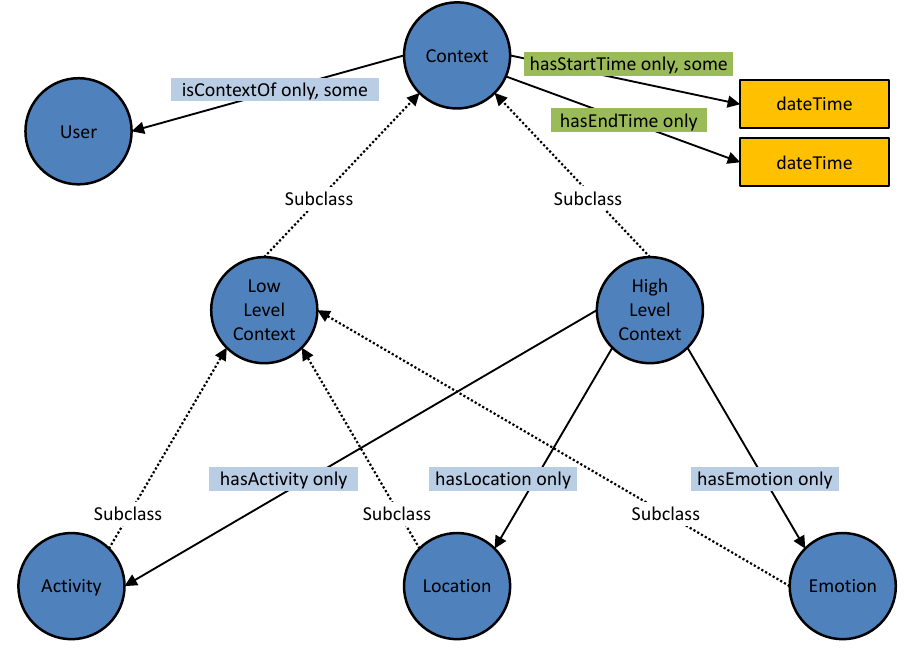
Figure 2. Mining minds context ontology: the class Context , its subclasses and the relations among them.